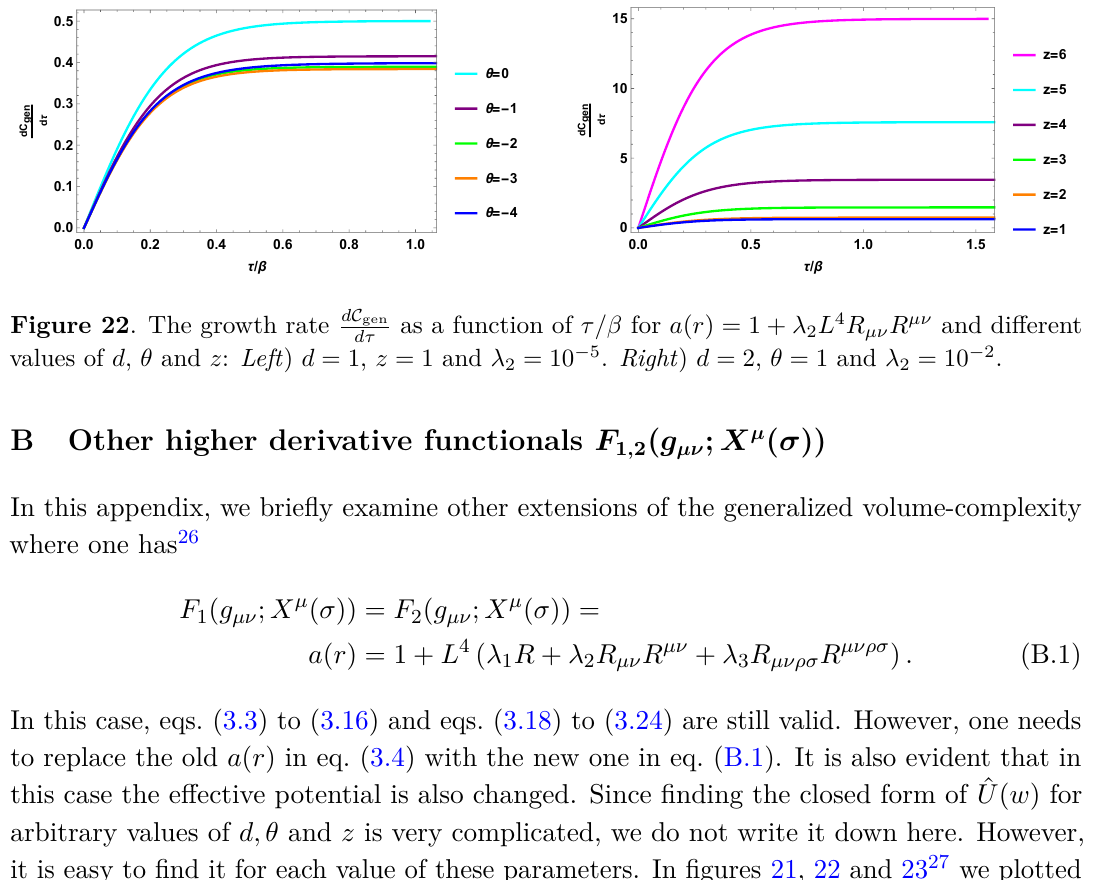
4 R and different values 1 L = 10 − 2 . 1